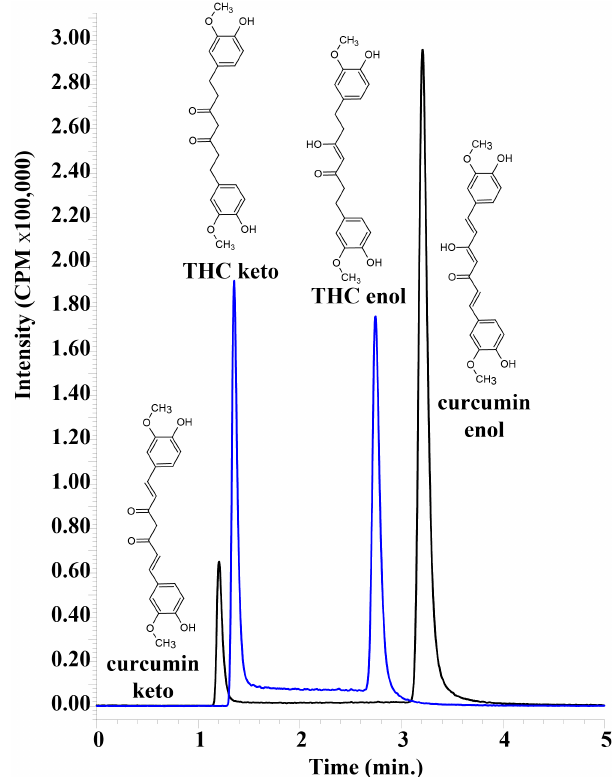
Figure 2. A representative chromatogram of curcumin and tetrahydrocurcumin (THC) Shown are the enol and keto forms of curcumin and THC using the LC–MS/MS assay. Both compounds are at a concentration of 1 µg/mL dissolved in acetonitrile.